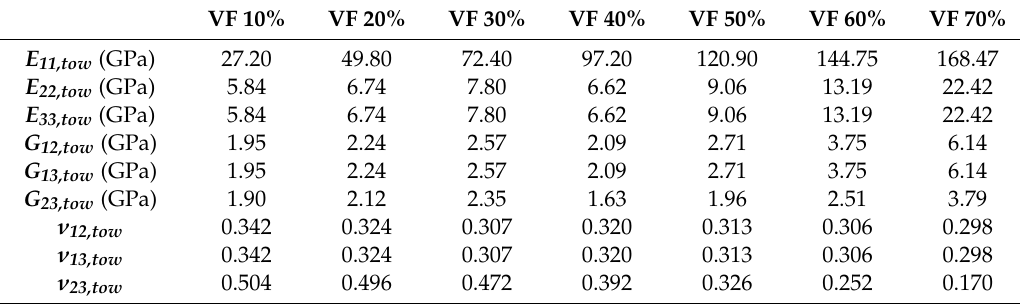
Table 2. Homogenization analysis results of the micro-level.